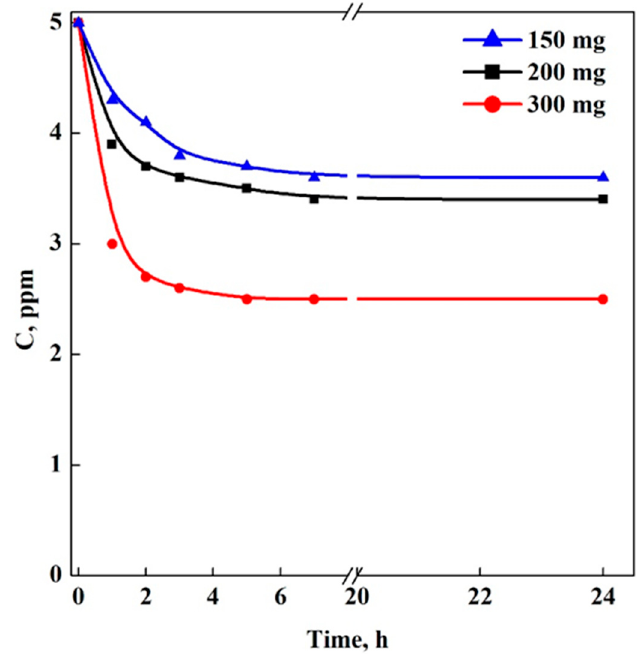
Figure 3. Adsorption kinetics of aerogel samples analyzed in the experiments of Set A (Aerogels) performing a batch adsorption (T = 25 °C, rpm = 200, λ = 591) and using three different amounts of aerogels: 150 mg (blue line), 200 mg (black line) and 300 mg (red line).